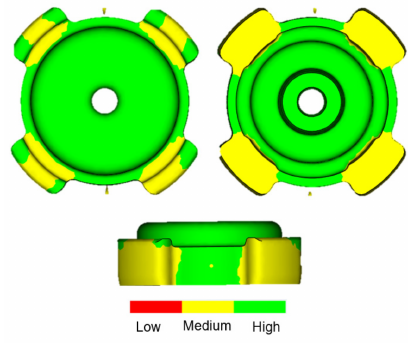
Figure 3. ( a ) Confidence to fill and ( b ) pressure drops.